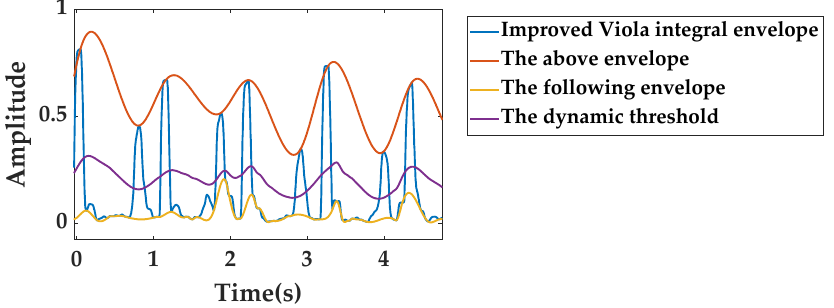
Figure 4. The dynamic threshold. Blue line is the improved Viola integral envelope. The red and yellow line represent above and following envelopes. The purple line represents the dynamic threshold.